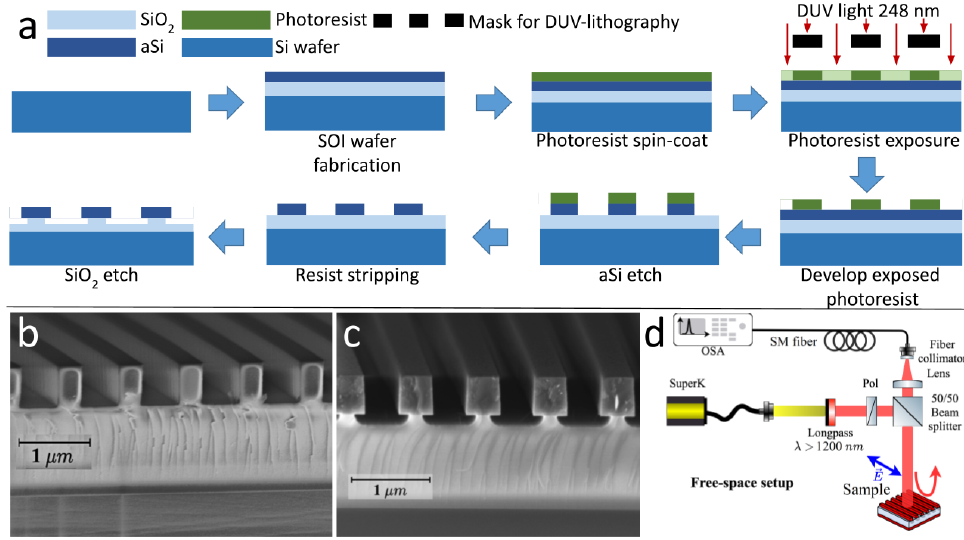
Figure 2. ( a ) Schematic of the fabrication process for the pedestal-grating, ( b ) SEM image of the